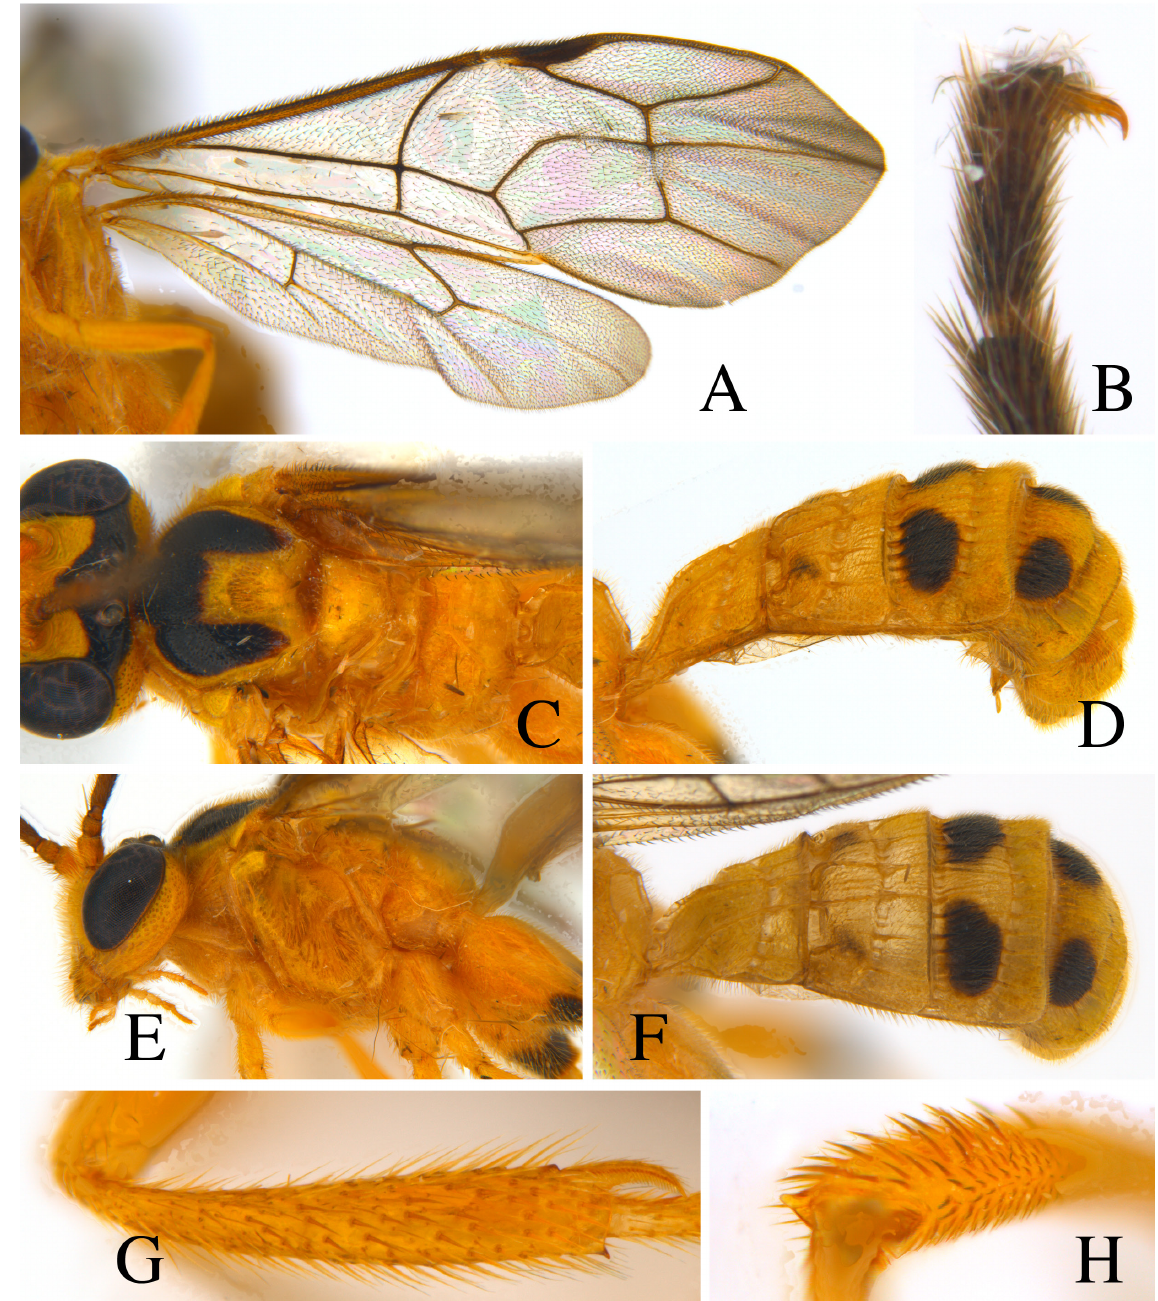
Fig. 2. Rhytidaphora thailandica Reshchikov & Quicke gen. et sp. nov., holotype, ♀ (CUMZ). A . Wings. B . Tarsal claw. C . Head and mesosoma dorsally. D . Metasoma laterally. E . Head and mesosoma laterally. F . Metasoma dorsally. G . Fore tibia laterally. H . Fore tibia